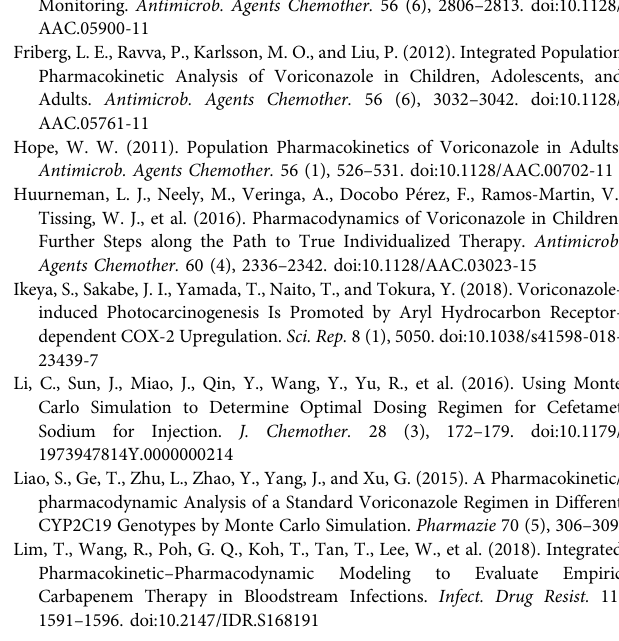
Supplementary Figure S1 | The goodness-of- fi t (GOF) plots of the PPK model: individual predictions (IPRED) and population predictions (PRED) versus the observed values and plots for conditional weighted residuals (CWRES) versus PRED, and CWRES versus time after dose. Supplementary FigureS2 |Visual predictive checks for thePPK model. Solidlines indicate the 50th percentile of the observed data, dash lines indicate the 5th and 95th percentile of the observed data. The purple shaded areas in this fi gure indicate the 90% con fi dence interval of the 5th and 95th of the simulated data, the pink shaded areas show the 90% con fi dence interval of the 50th of the simulated data from the PPK